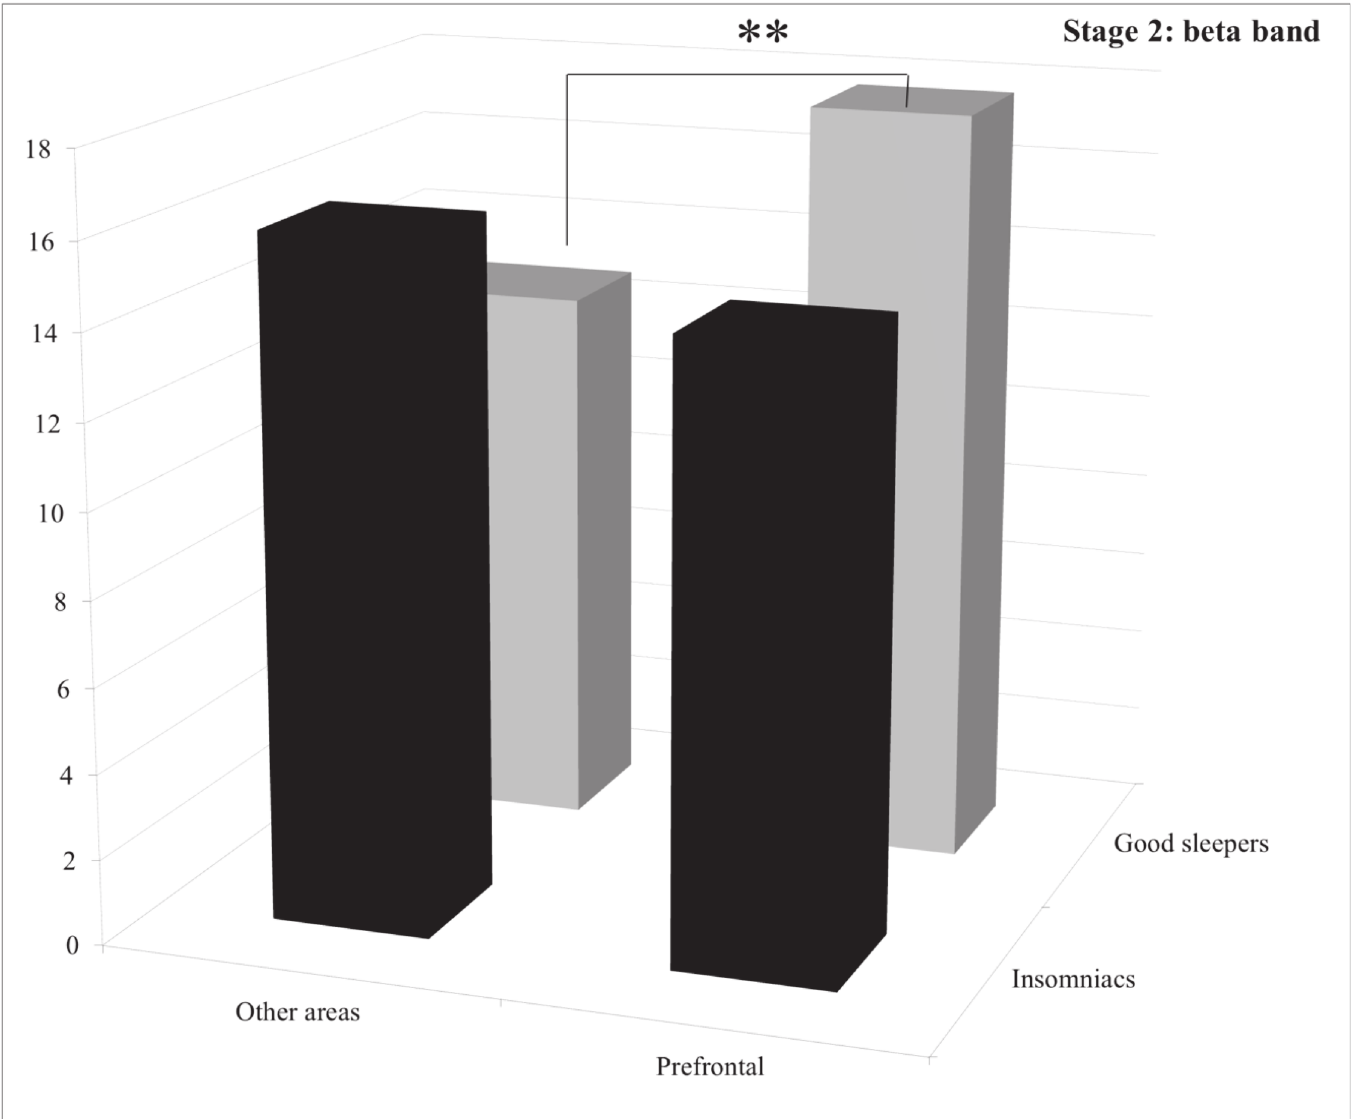
Figure 2. Relative power spectra for the beta band during stage 2 for both groups (insomnia patients and good sleepers) and each areas (others vs prefrontal). ** p <